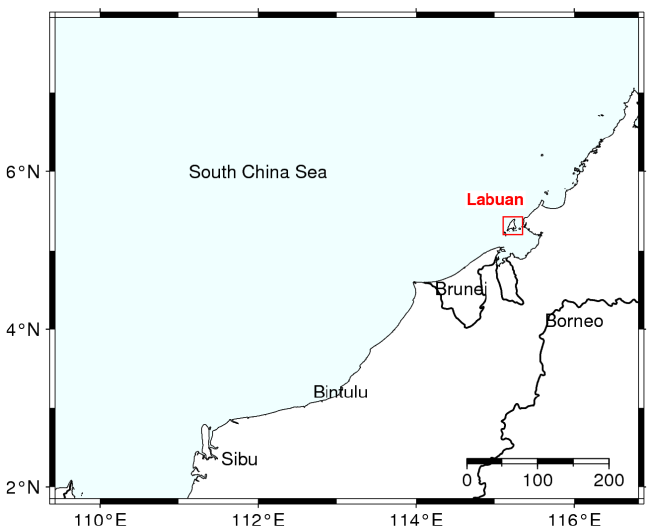
Figure 1. A locational map of Labuan Island in relation to the South China Sea and Borneo.